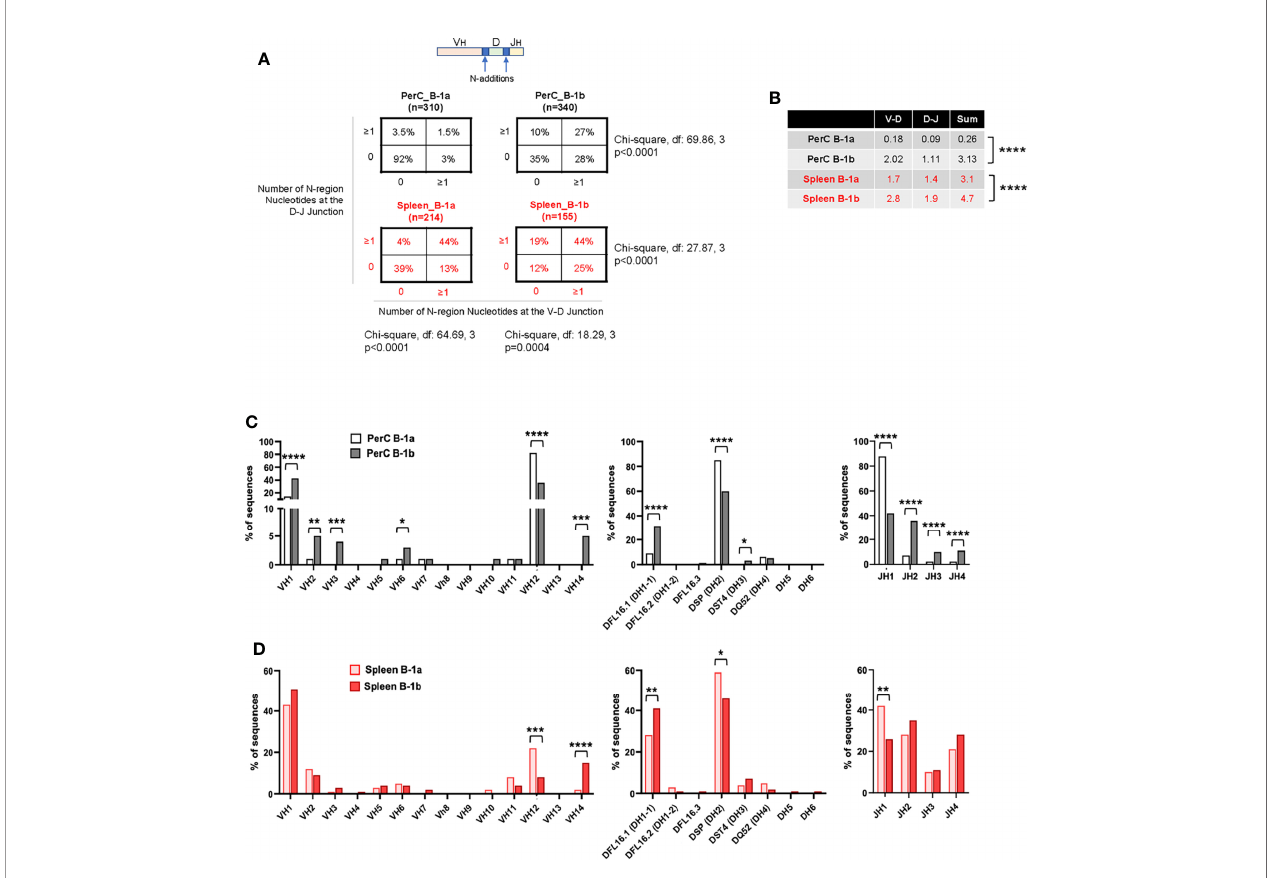
FIGURE 5 | B-1b cells have distinct IgHV repertoires for IgM in aged atherosclerotic ApoE -/- mice. (A) Percentage of total sequences with 0 N-additions at both V-D and D-J junctions (lower left), 1 or more N-additions at both junctions (upper right), or one or more N-addition at either the V-D or D-J junction (upper left or lower right) in the variable region of the immunoglobulin heavy chain of sorted B-1a and B-1b cells from PerC and spleen. (B) Average number of N-additions at either the V-D junction, the D-J junction, or the average sum of N-additions at both junctions in sorted PerC and spleen B-1a and B-1b cells. ****P<0.0001 by Mann-Whitney t-test. (C, D) Frequency of total sequences utilizing the given V H , D, and J H gene segments in the variable region of the immunoglobulin heavy chain from single cell- sorted B-1a and B-1b cells in (C) PerC and (D) spleen of 100-week-old chow-fed ApoE -/- mice. *P < 0.05, **P < 0.01, ***P < 0.001, ****P <